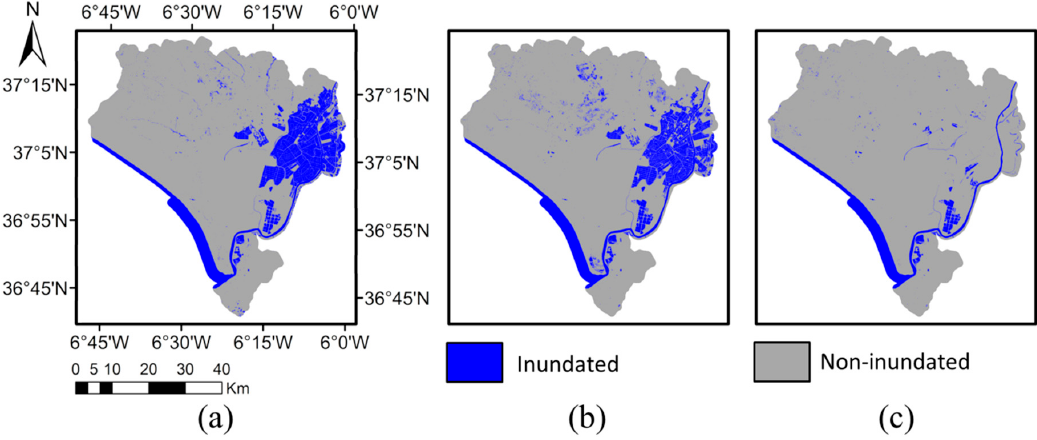
Figure 14. Inundation map generated on 20 August, 2017 using: ( a ) “Alt1 (MCET)”, ( b ) “Alt2 (MCET)”, and ( c ) “Alt3 (MCET)” alternatives. Blue and gray colors correspond to inundated and non-inundated areas, respectively.